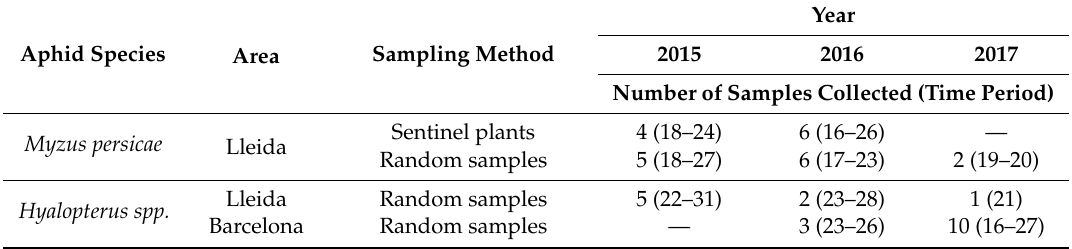
Table 1. Sampling conducted to identify the parasitoid and hyperparasitoid species associated with M. persicae and Hyalopterus spp. and their abundance in peach trees. The time period of the samples collected is expressed in week numbers, where week 16 corresponds to mid-April and week 31 to end of July.